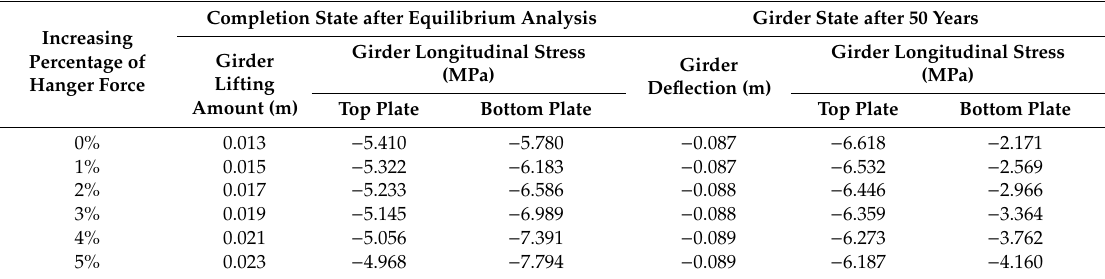
Table 11. Parametric analysis result of the influence on girder state evolution brought by final girder geometry.